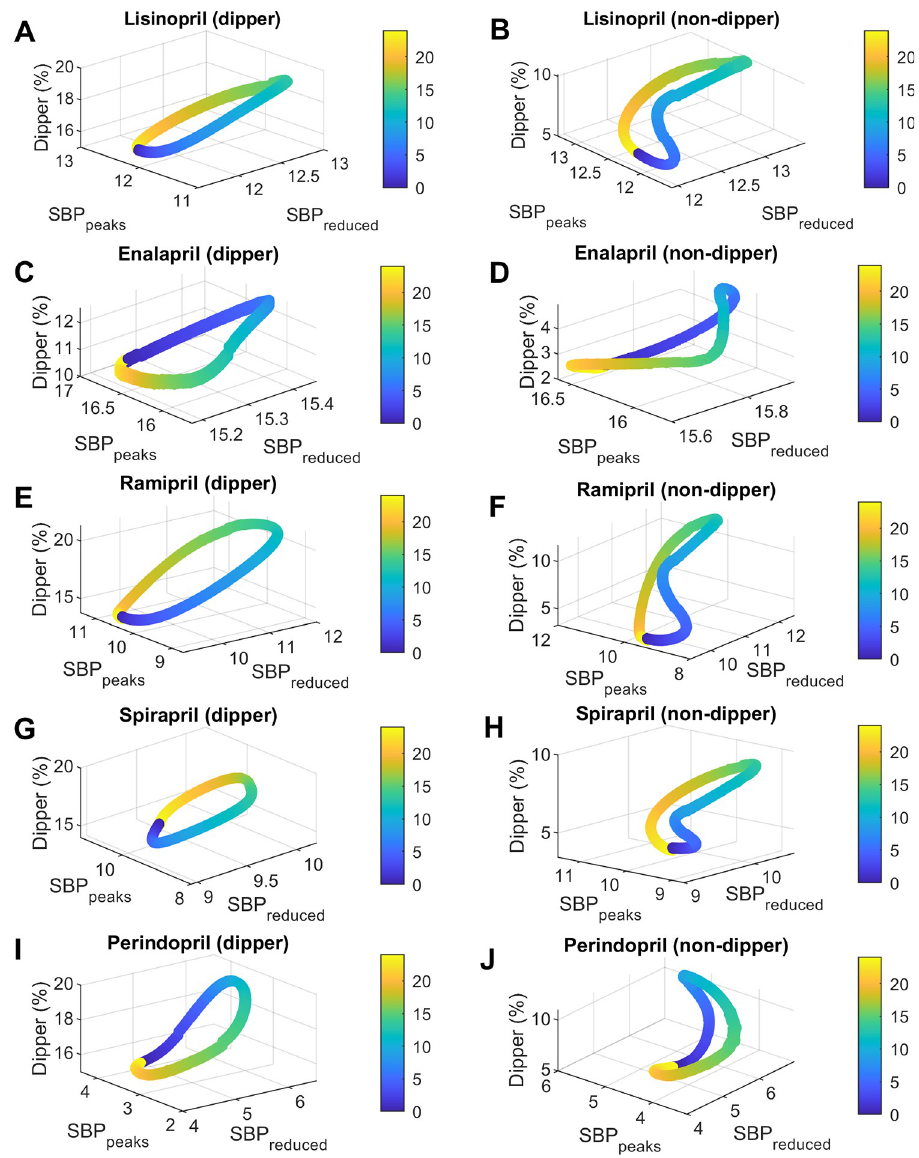
Fig 6. Relationship between dosing time and SBP dipper percentage, average SBP reduction ( SBP reduced ), and average SBP peaks reduction ( SBP ) for lisinopril, enalapril, ramipril, spirapril and perindopril. The figures on peaks the left show the results for dipper subjects and those on the right for non-dipper. Fig 6A and 6B, lisinopril; Fig 6C and 6D, enalapril; Fig 6E and 6F, ramipril; Fig 6G and 6H, spirapril; Fig 6I and 6J, perindopril. Dosing time ( Ta ) is represented in colors from 0 to 24 hours after awakening